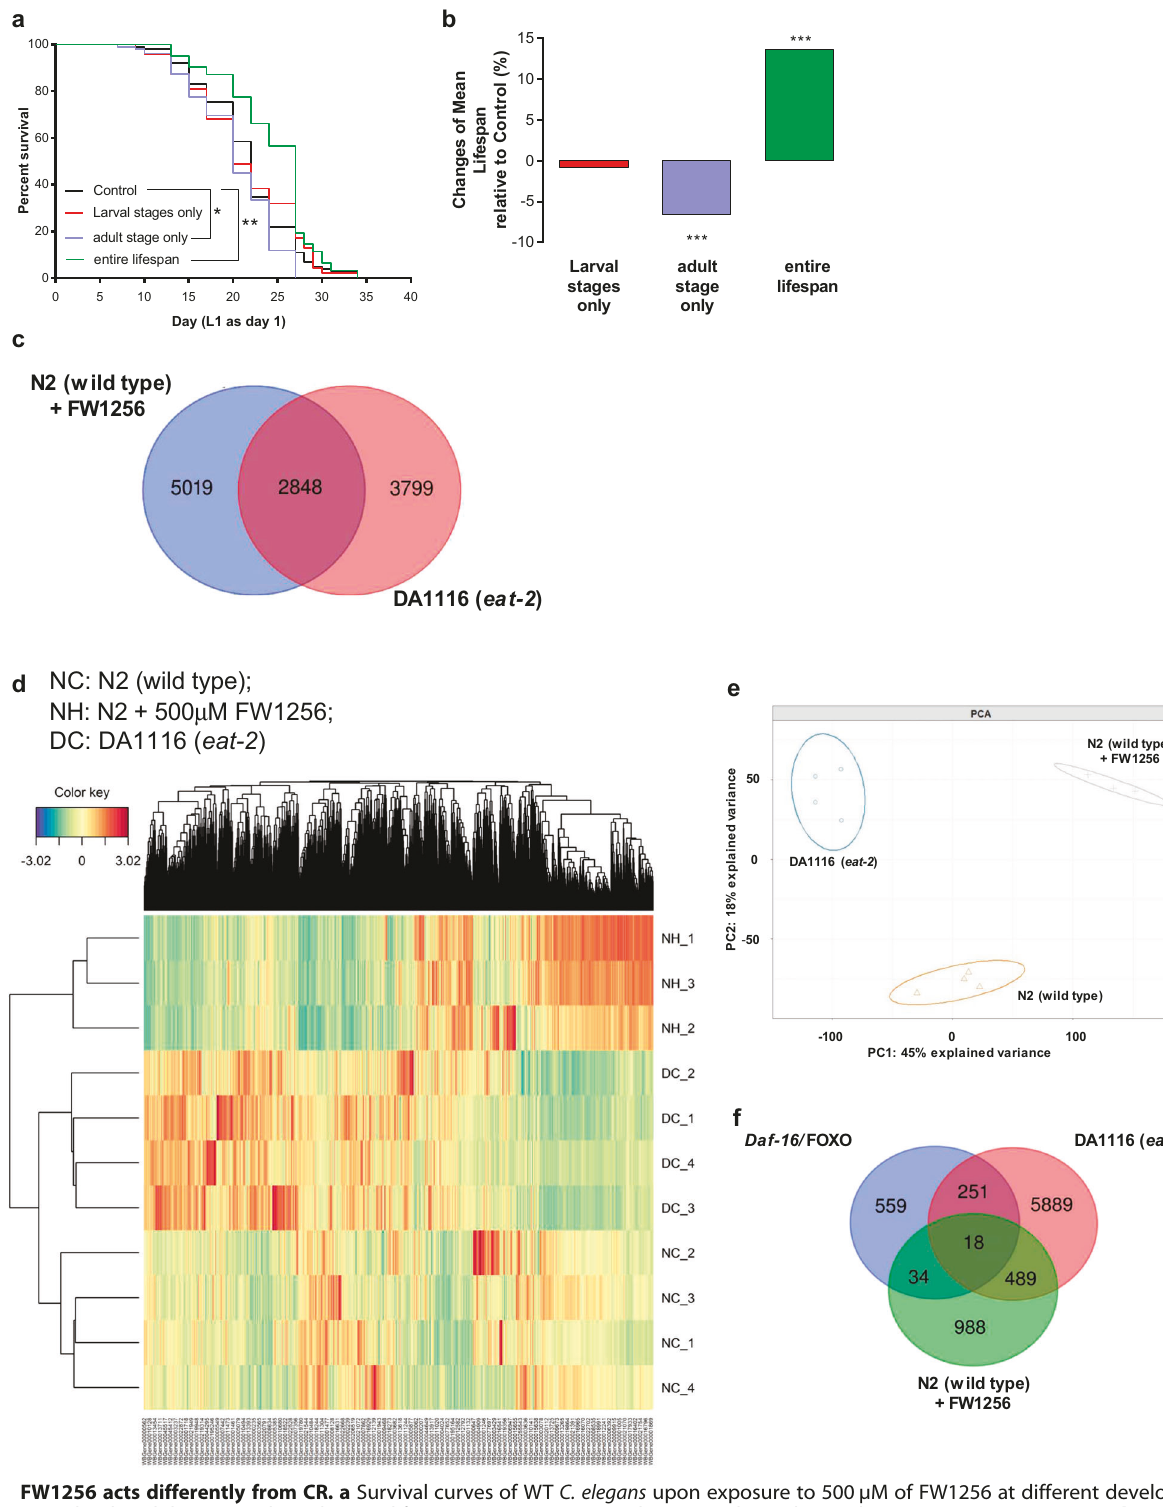
Fig. 6 FW1256 acts differently from CR. a Survival curves of WT C. elegans upon exposure to 500 µM of FW1256 at different developmental stages: Larval only, adult stage only and entire lifespan ( n = 47 – 102 animals per condition, log-rank tests, * p < 0.05, ** p < 0.01). b Percentage change in mean lifespan relative to control ( n = 47 – 102 animals per condition, mean lifespans were analyzed using OASIS2, *** p < 0.001). c Venn diagram of genes differentially expressed following exposure to FW1256 or in eat-2 mutants, relative to WT controls (Hypergeometric test, *** p < 0.001). d Heatmap and cluster analysis of all genes with expression differences in unexposed WT, WT exposed to FW1256 and unexposed eat-2 mutants. e PCA of unexposed WT, WT exposed to FW1256 and unexposed eat-2 mutants. f Venn diagram of genes downstream of Daf-16 /FOXO that are affected following exposure to FW1256 or in eat-2 mutants (Hypergeometric test, non-signi fi cant, p >